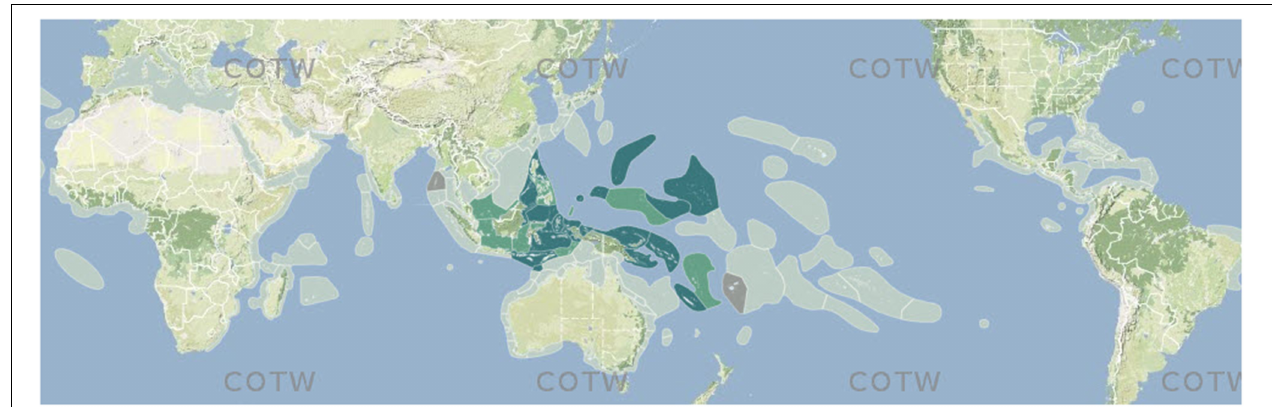
FIGURE 3 | Example of a species map from Corals of the World. Off-white, no record; dark green, confirmed record; pale green, strongly predicted record; tan, published record that warrants further investigation.